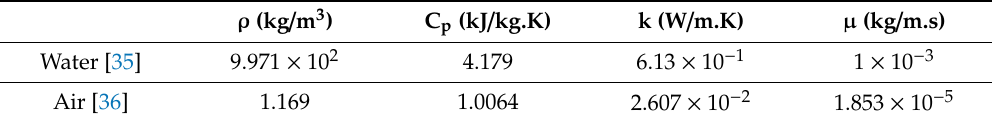
Table 2. Properties of air and water in room temperature and